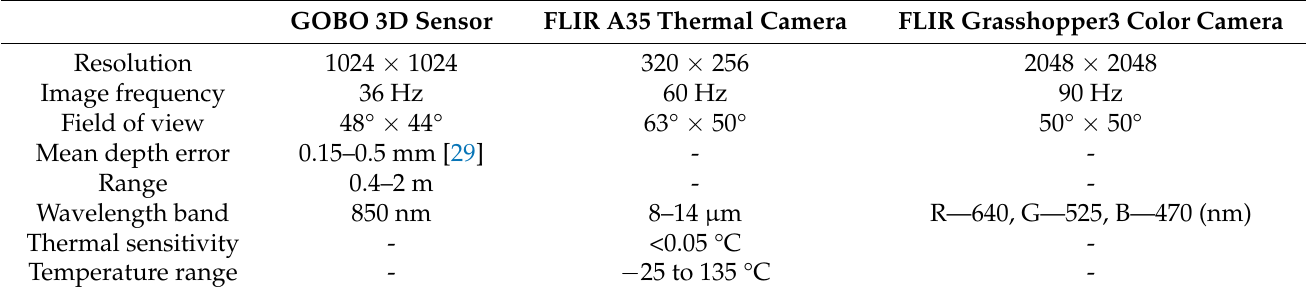
Table 1. Technical data of the used camera